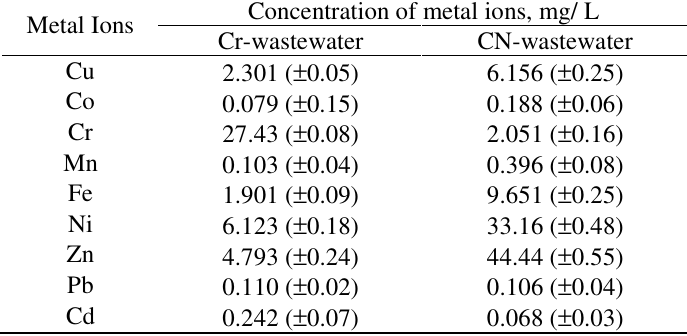
Table 1. Heavy metal concentration in the wastewater test at pH